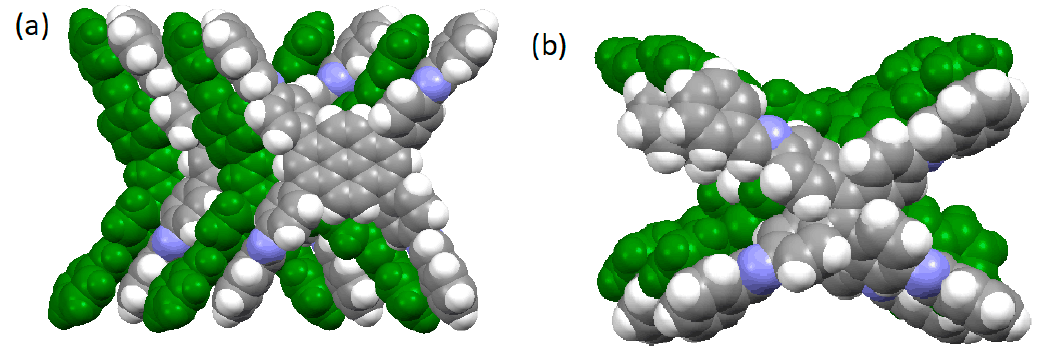
Figure 16. Different packing fashions between building units observed in the discrete model compounds of ( a ) 4PE-1P COF with 1,1,2,2-tetraphenylethene as the central unit and ( b ) Py-1P COF with 1,3,6,8-tetrakisphenylpyrene as the central unit, respectively.